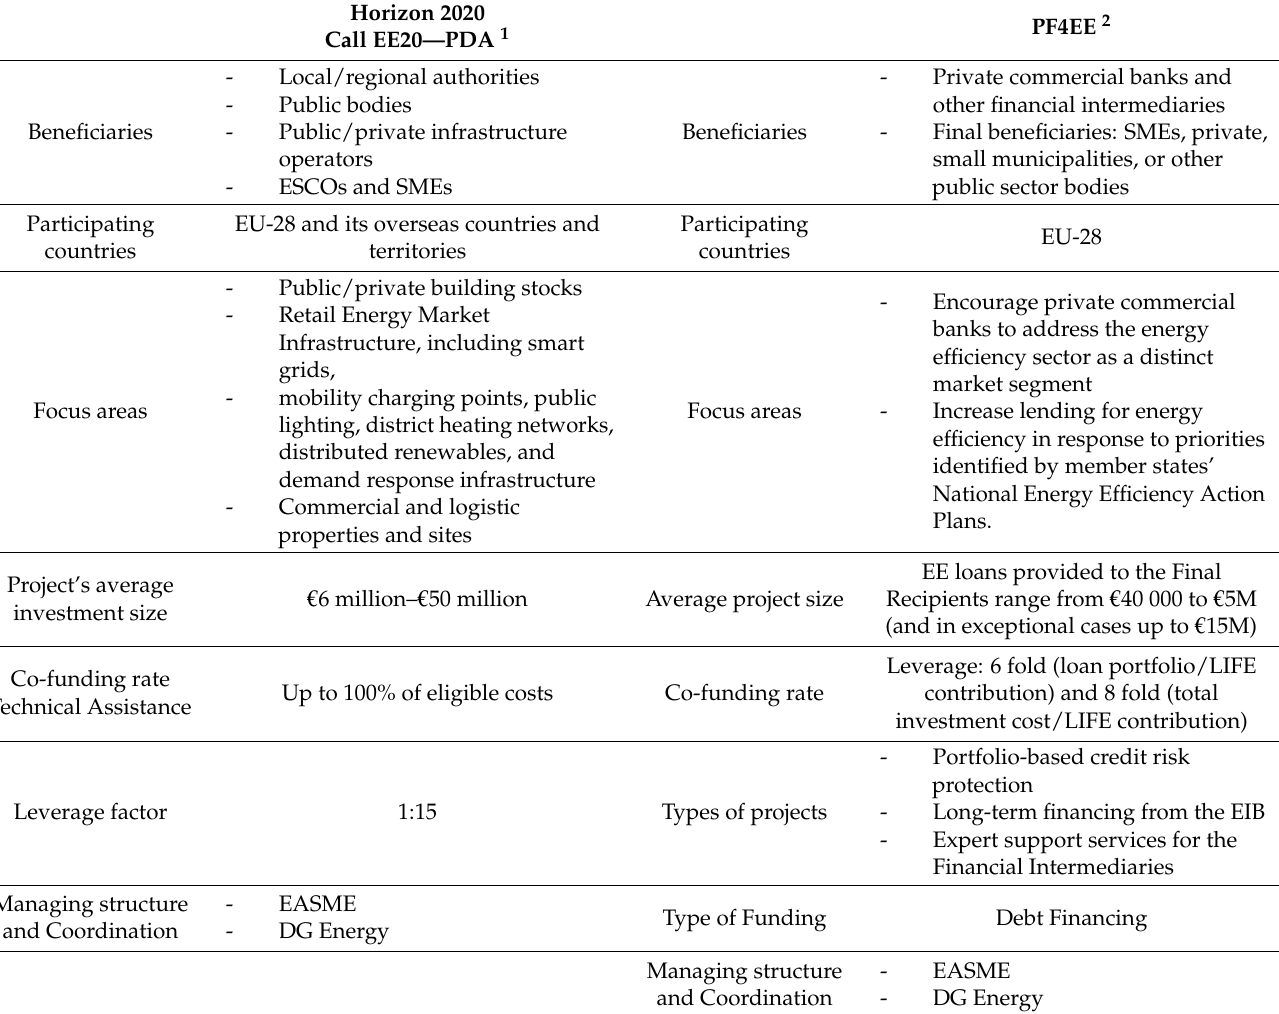
Table A4. European project development assistance facilities, EU financial